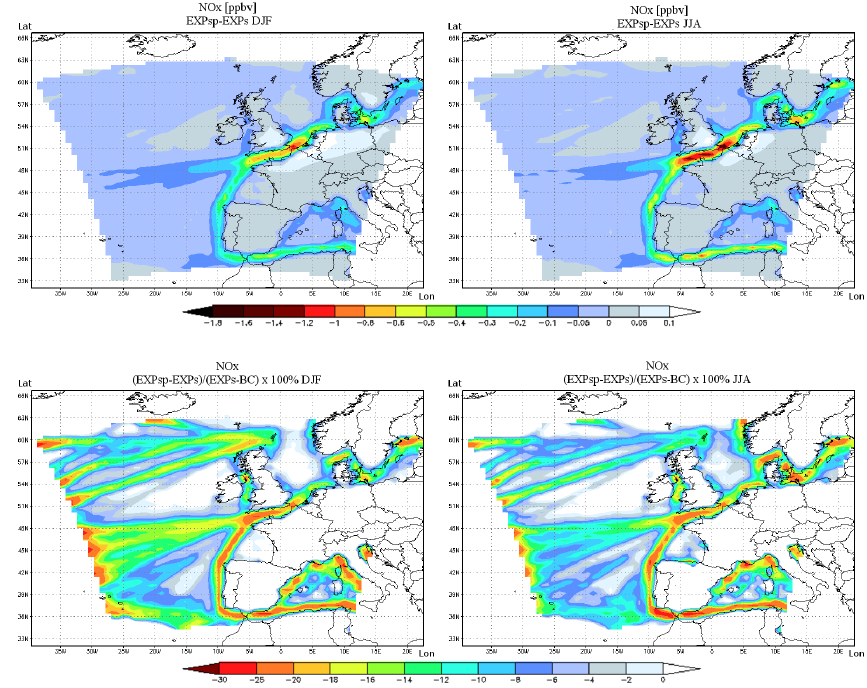
Fig. 7. Top row: difference of surface NO x of experiments EXPsp and EXPs in ppbv for winter (left) and summer conditions (right). Bottom row: the ship induced NO x production change as (EXPsp-EXPs)/(EXPs-BC) ×